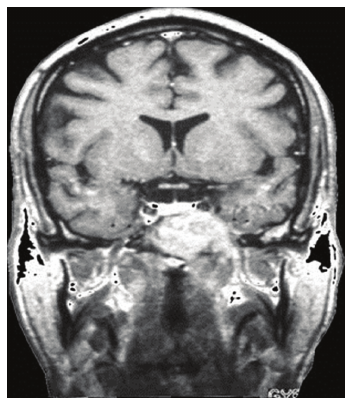
Figure 2: Cranial MRI before radiotherapy.